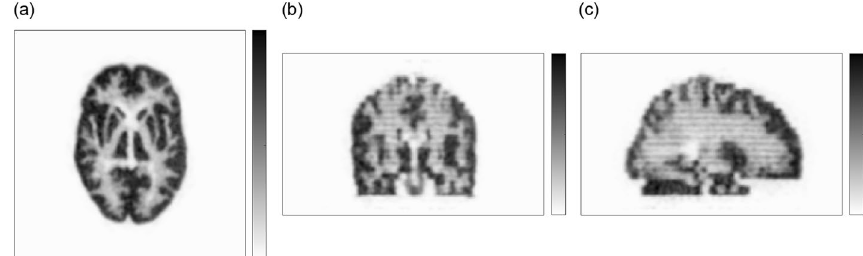
Fig. 6 Representative slices of the 3D Hoffman brain phantom image: a transaxial, b coronal, c sagittal. The thin activity distribution in gaps was visible in both coronal and sagittal